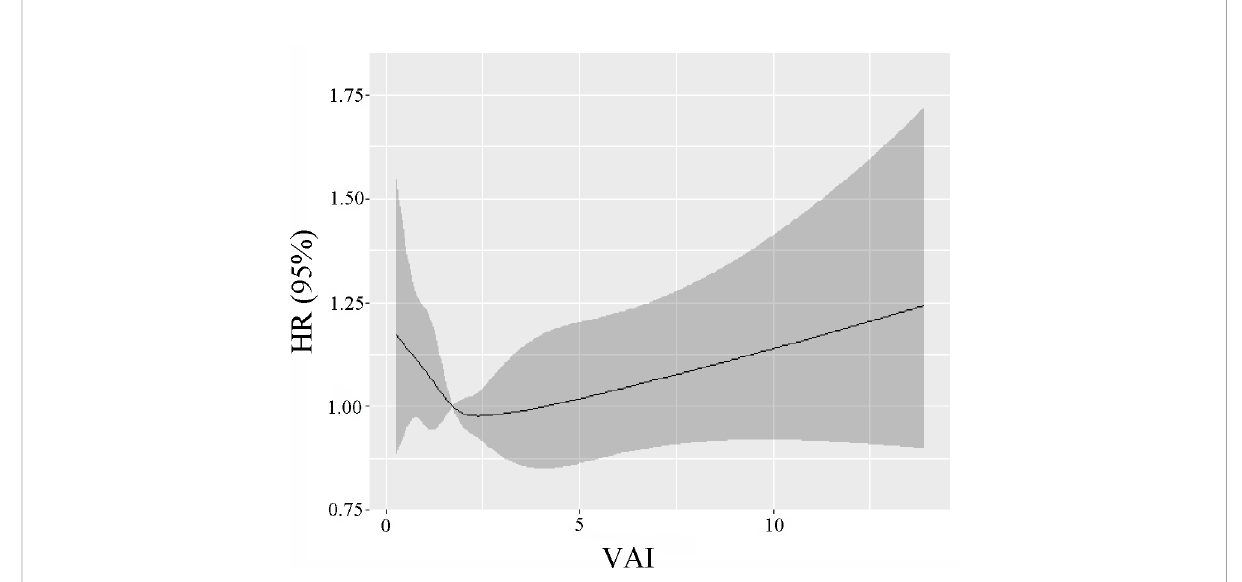
FIGURE 1 The unadjusted correlation between continuous VAI and all-cause mortality is demonstrated using generalized additive